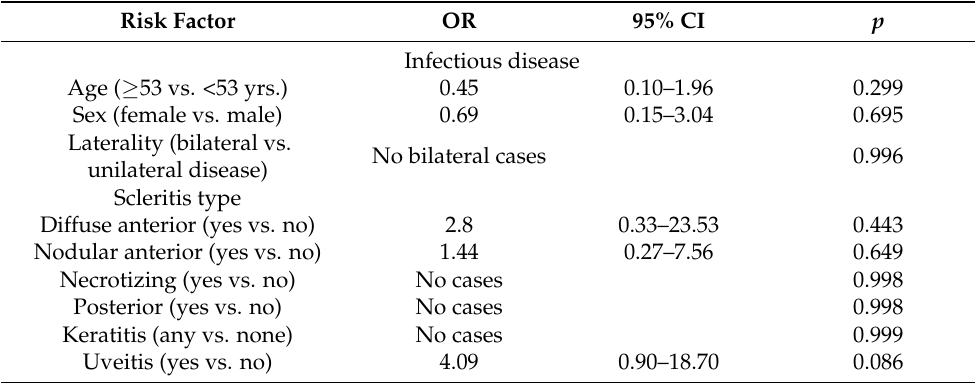
Table 3. Risk Factors for infectious or immune-mediated